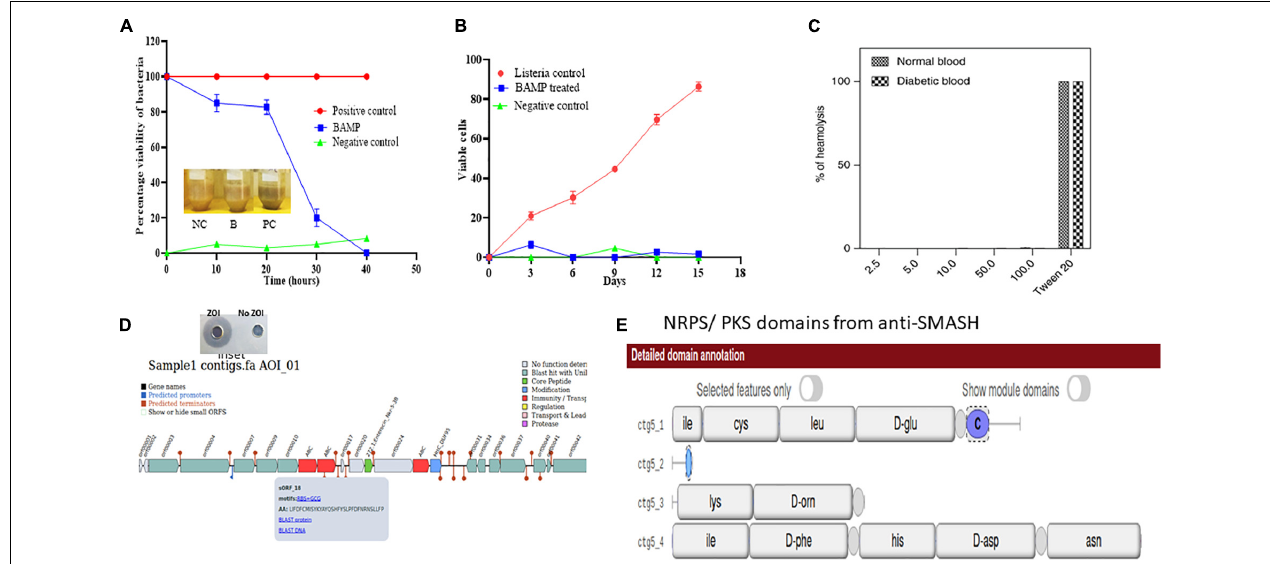
FIGURE 3 | (A) Viability of L. monocytogenes in chicken meat on treatment with Nisin and BAMP for 36 h at 37 ◦ C and 16 days at 4 ◦ C. The picture in the inlet of graph A shows the differences in appearance of treated and untreated samples. NC, negative control; B, BAMP-treated samples; PC, positive control. (B) L. monocytogenes viability curves after treatment with BAMP. (C) Hemolytic activity of BAMP on healthy and diabetic human blood samples. (D) Antimicrobial biosynthetic gene cluster in the genome sequence of B. paralicheniformis. The inset shows ZOI and No-ZOI, predicted through BAGEL 3. (E) Non-ribosomal peptide predicted using